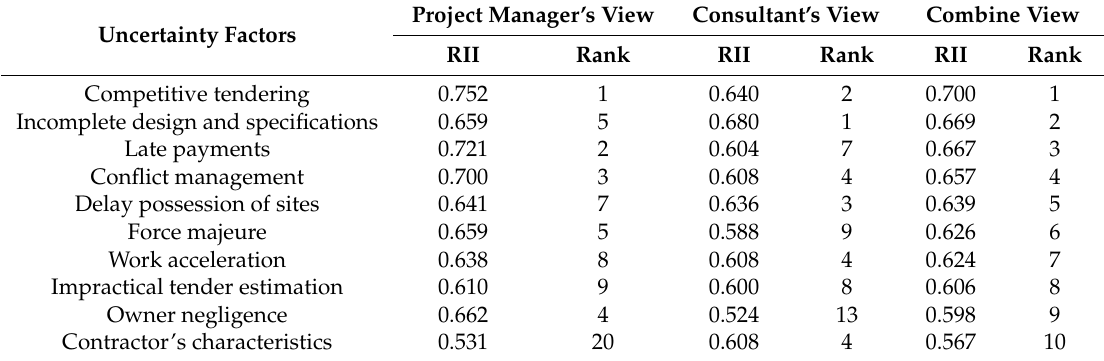
Table 5. Ranking of Importance Index of Major factors that escalate transaction cost